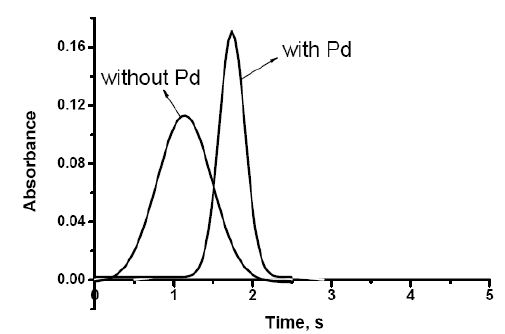
Fig. 1 Absorbance peaks for Pb in the presence of wine with and without modifier